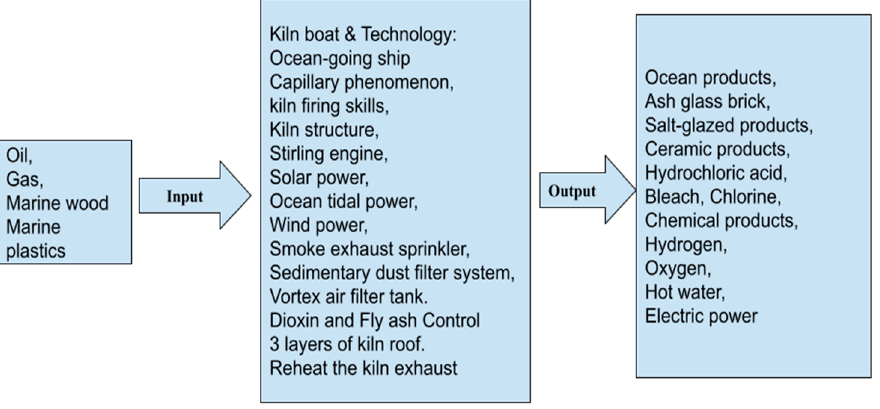
Figure 6. Overview of kiln boat plan.